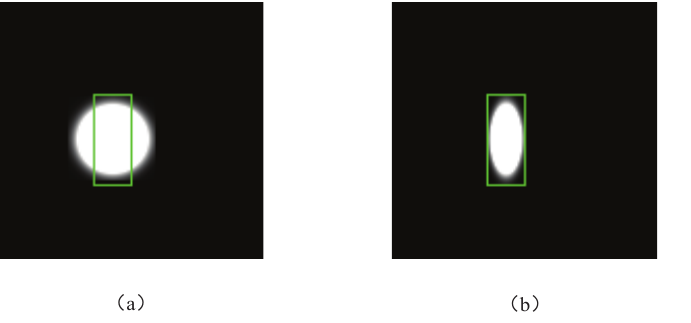
Figure 4. The heatmaps of different Gaussian kernel: ( a ) the Gaussian kernel; ( b ) the adaptive Gaussian kernel.